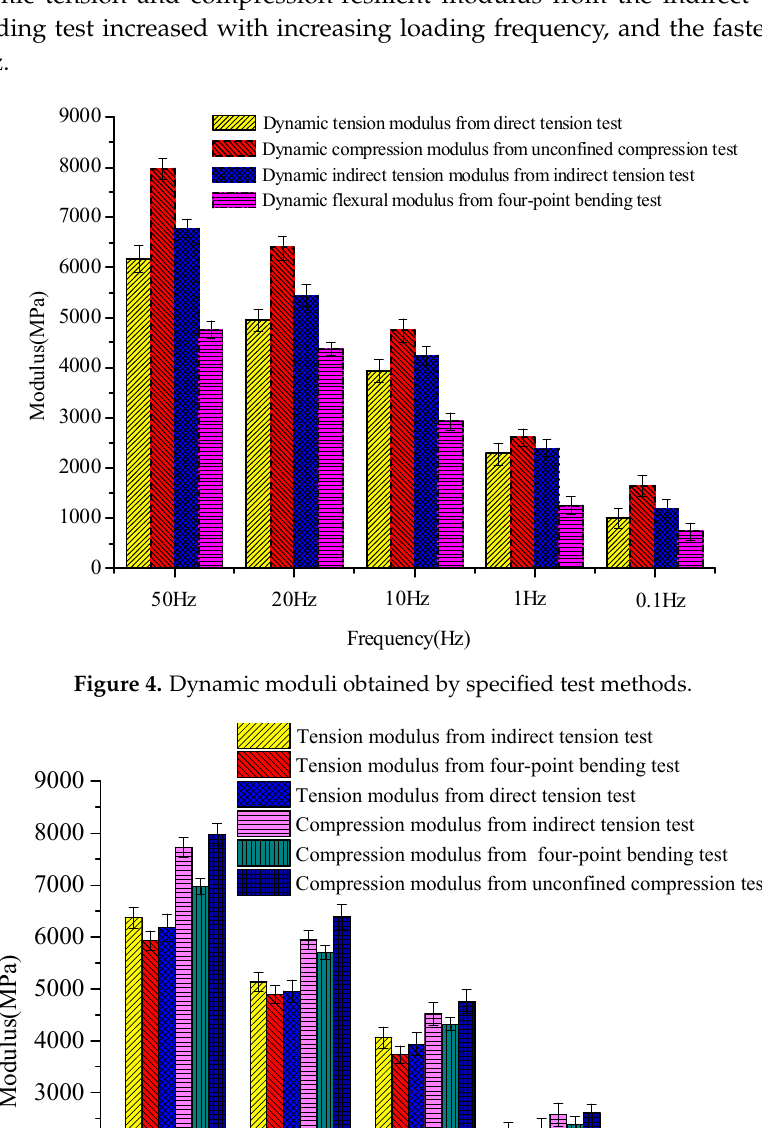
Figure 6. Fitting parameters of different dynamic resilient moduli under different loading frequencies is shown in Table 5.